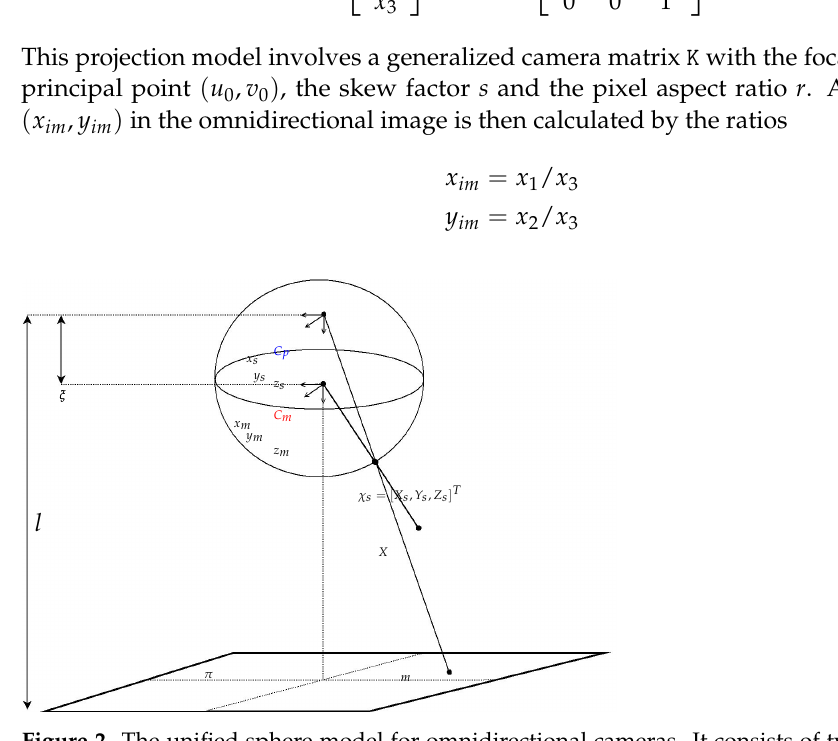
Figure 2. The unified sphere model for omnidirectional cameras. It consists of two linear projec- tion